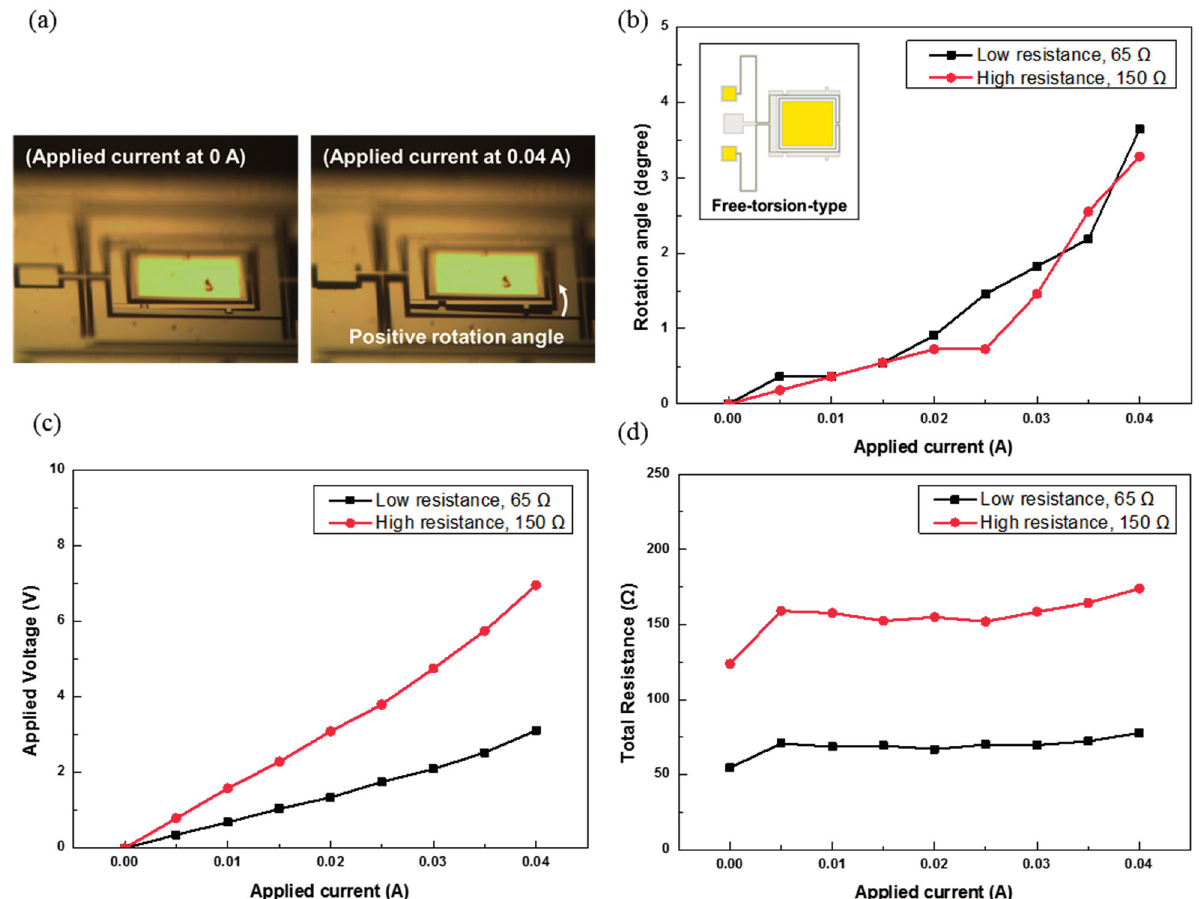
Figure 7. Experimental results for the free-torsion-type MEMS mirrors of different wire resistances: ( a ) optical microscope images; ( b ) rotation angles; ( c ) applied voltages; and ( d ) total resistances.